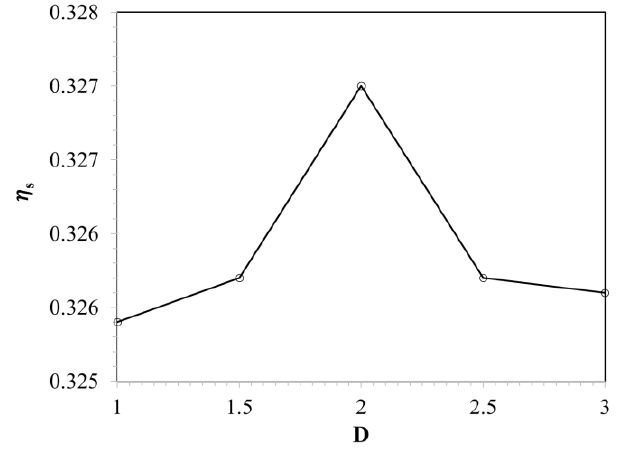
Figure 9. 𝜂 𝑠 with expansion behind the inlet hole. Figure 9. η s with expansion behind the inlet